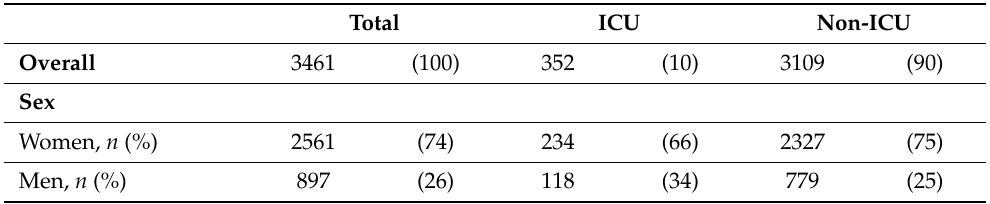
Table 1. Descriptive characteristics of the participants ( n =